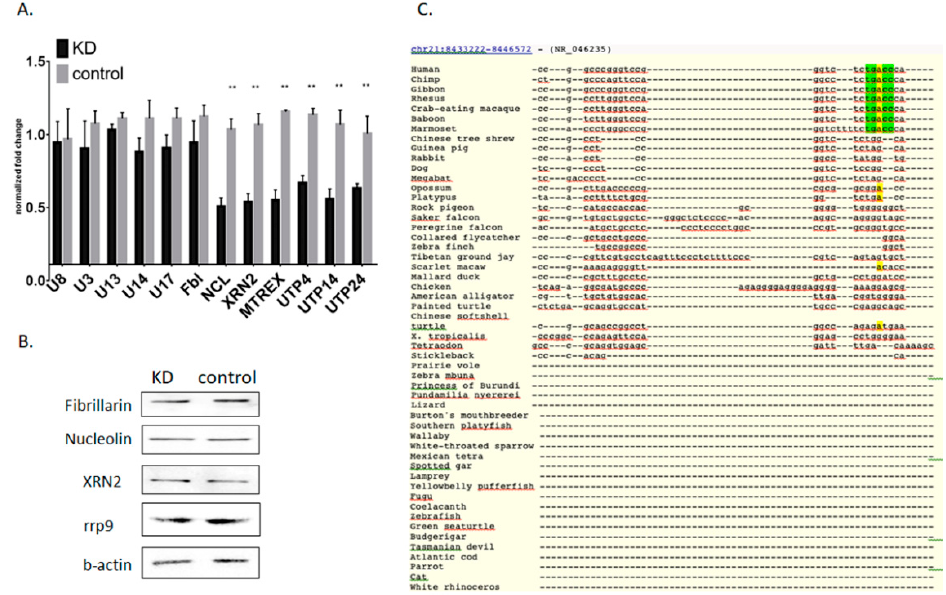
Figure 3. Changes of pre-RNA processing machinery after 4 days of Mettl3 KD. ( A ) Quantification of RT-qPCR data (* p < 0.05, ** p < 0.01) and ( B ) Western blot analysis of the rRNA processing factors in control and Mettl3 KD cells. ( C ) Multiple sequence alignment of the 5 ′‐ ETS part with the modified m6A nucleotide (marked in yellow) in different species. Nucleotides of DRACH sequence are marked in green.